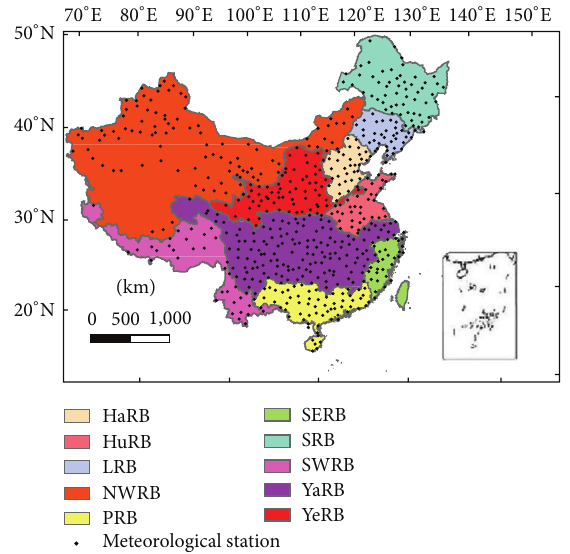
Figure 1: Spatial distribution of meteorological stations and first- order basin in